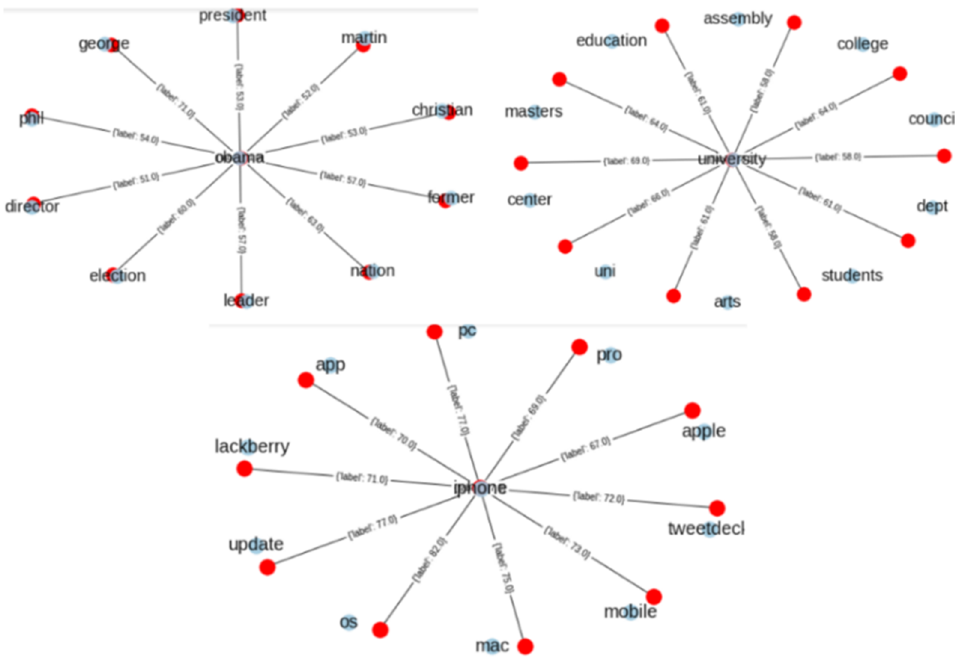
Figure 7. Word embedding after training the dataset with a minimum count of 5000.